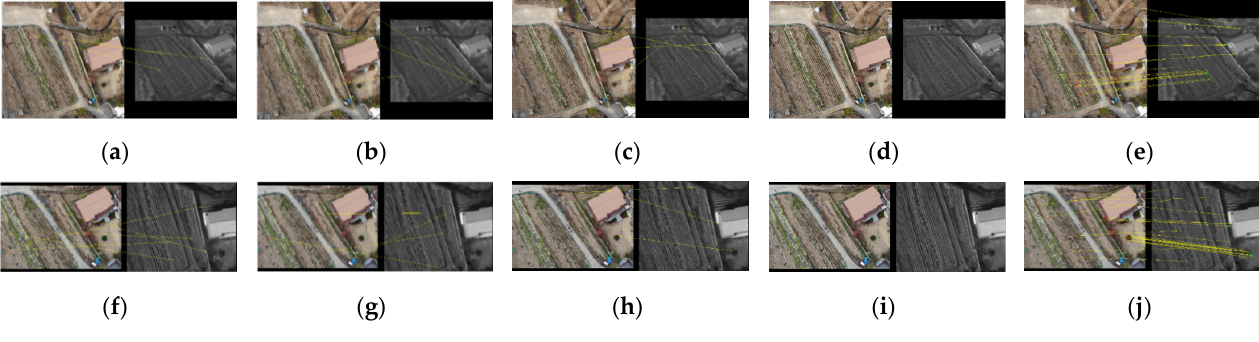
Figure 8. Matching results of non-building type images: visible nadir-looking (659 × 629) vs. TIR oblique (545 × 437) case: ( a ) SIFT, ( b ) SURF, ( c ) SAR–SIFT, ( d ) ASIFT, and ( e ) proposed method; visible oblique (669 × 460) vs. TIR nadir-looking (605 × 494) case: ( f ) SIFT, ( g ) SURF, ( h ) SAR–SIFT, ( i ) ASIFT, and ( j ) the proposed method. Table 5. The number of inliers according to the results of matching